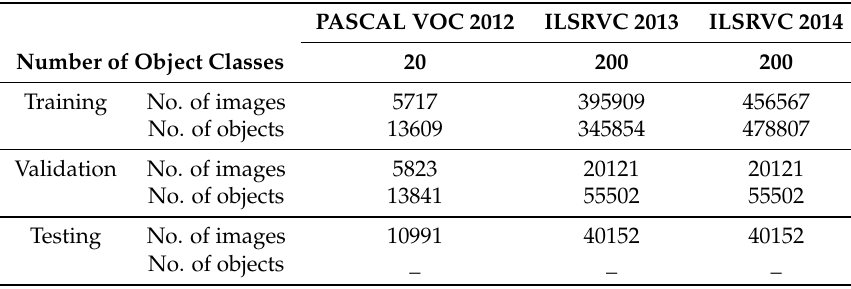
Table 7. Comparison of object detection datasets between PASCAL VOC and